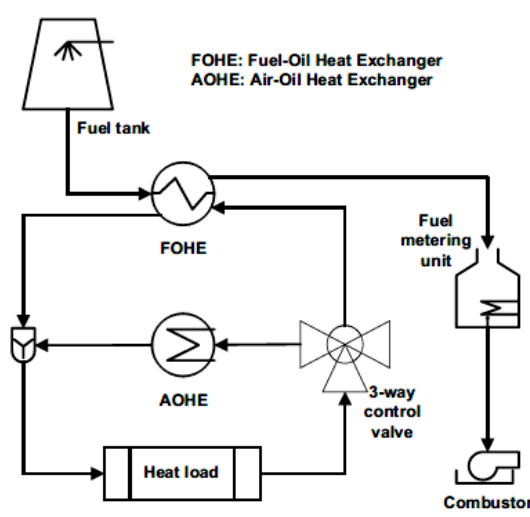
Figure 1. Typical thermal management system.